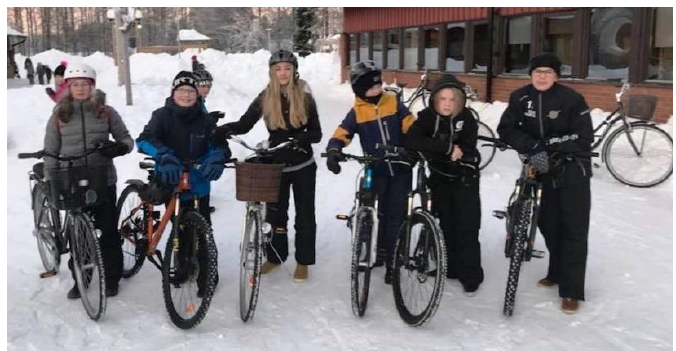
Figure 2. “When I arrive at school, and I see a lot of friends with bicycles there I feel a fellowship with the others biking to school; it is like some kind of belonging” Mathias C33.